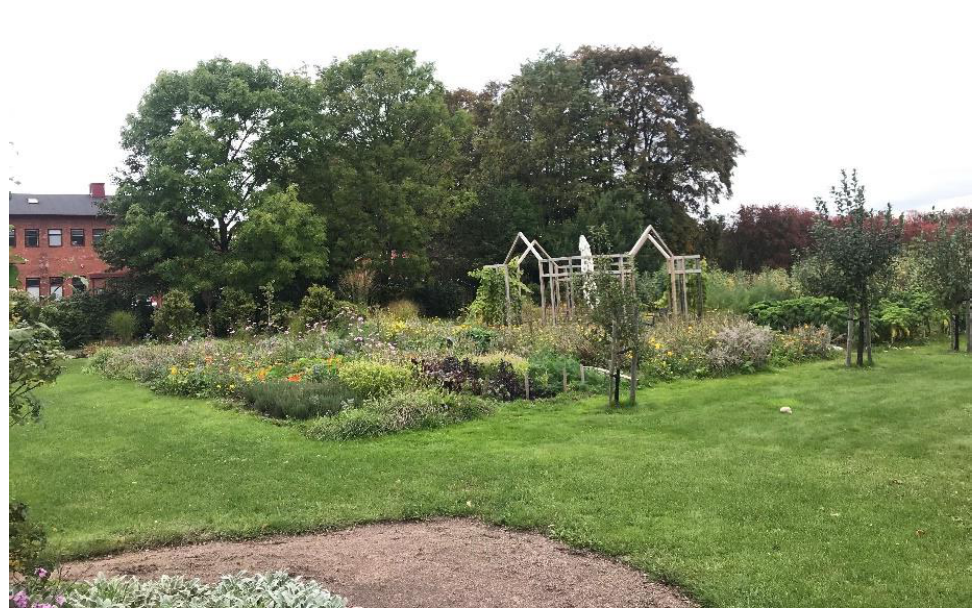
Figure 2. Alnarp Rehabilitation Garden, Sweden.